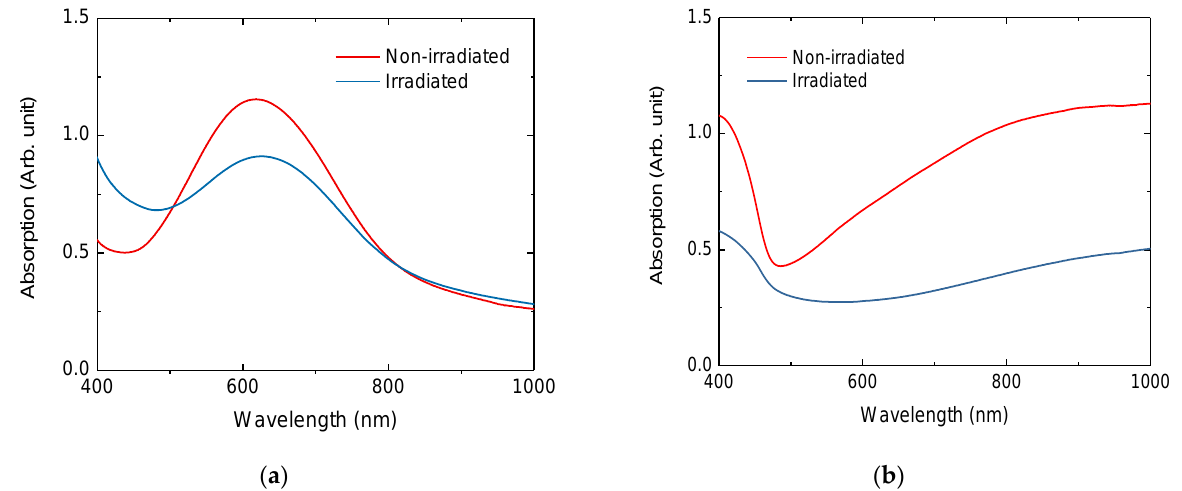
Figure 2. UV – visible spectrum of polyaniline (PANI) solution. Spectra of ( a ) emeraldine base (EB) PANI and ( b ) emerald- ine salt (ES) PANI. The red and blue lines indicate the spectrum before and after proton exposure with a fluence of 10 13 N/cm 2 , respectively.